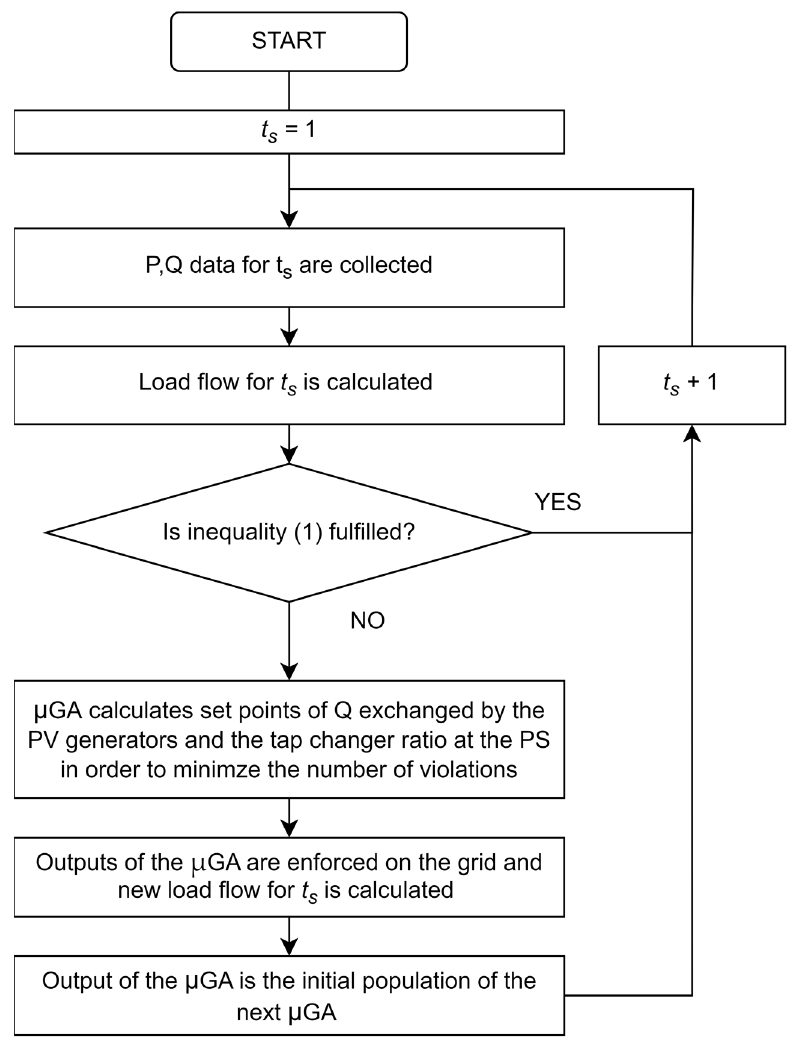
Figure 3. Flowchart of the voltage regulation framework.